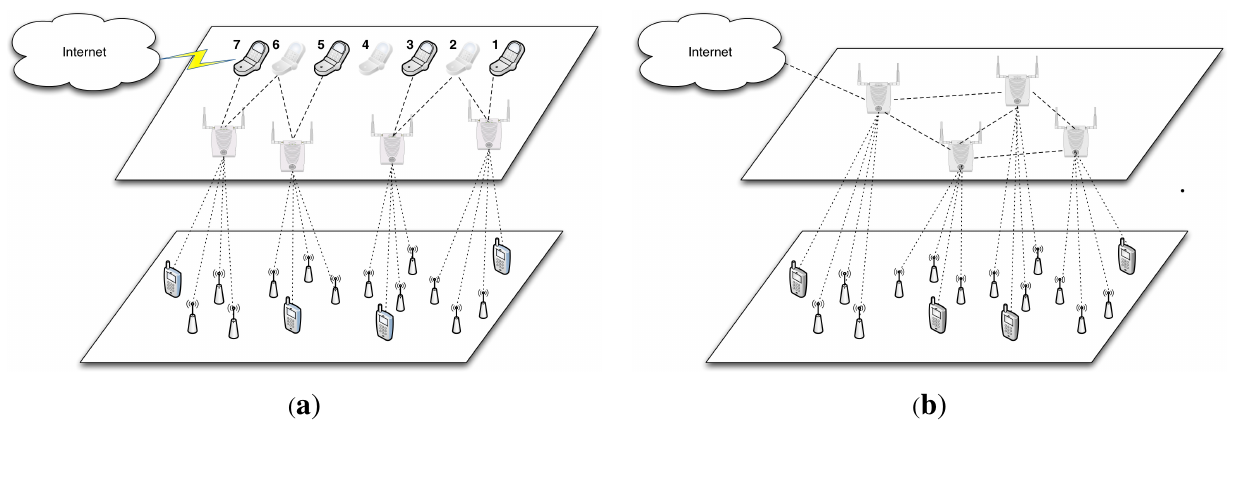
Figure 2. Long-range Deployment and Interoperability. ( a ) Multi Star with Mobile Sink; ( b ) Multi Star with Meshed